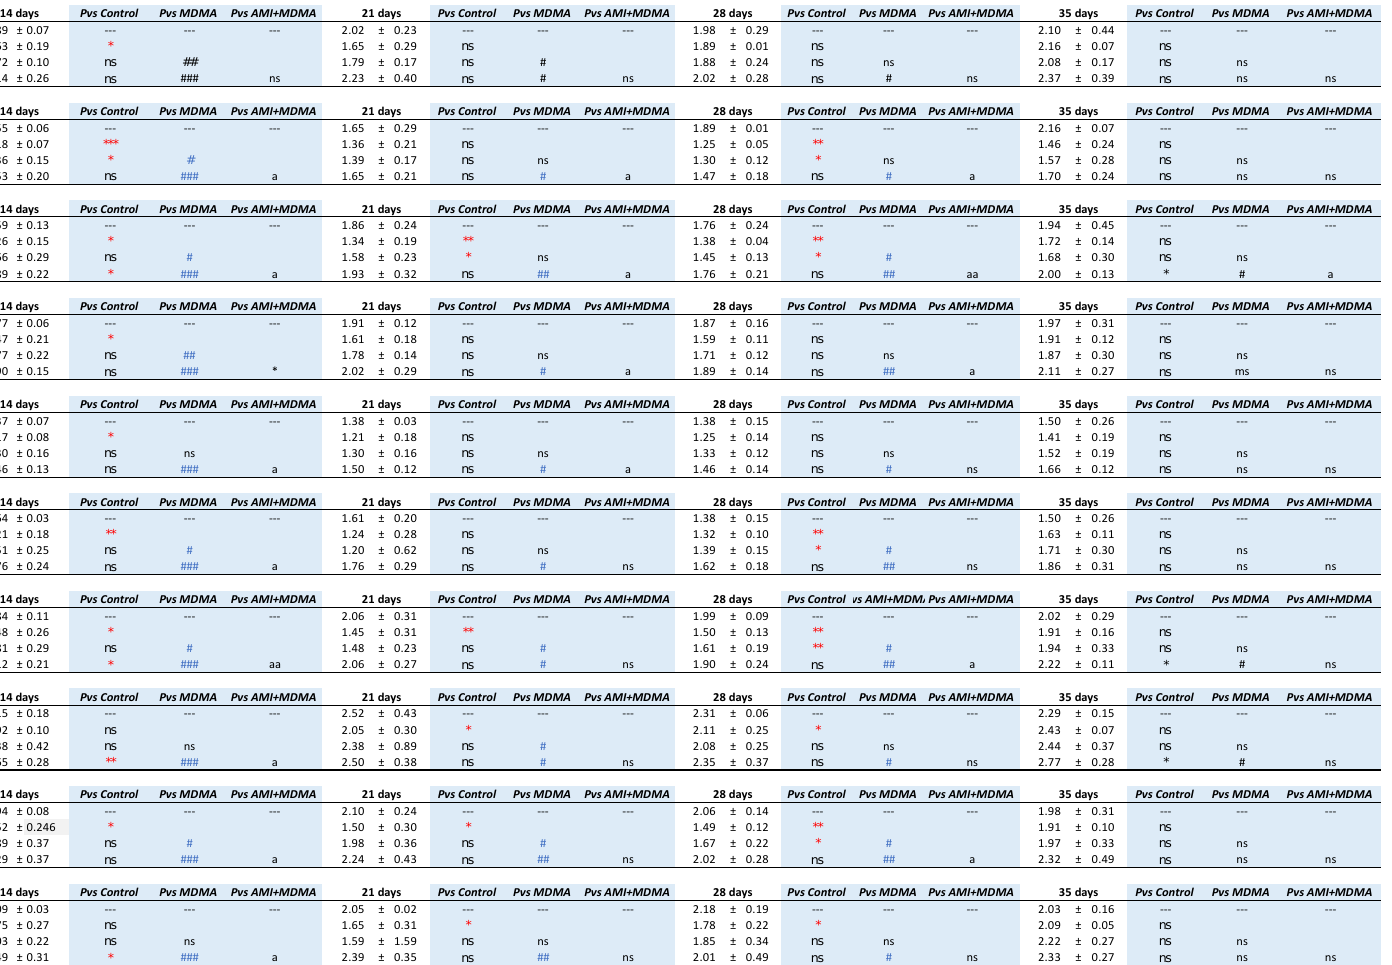
Figure 4. Specific uptake ratios (SURs) of 4-[ 18 F]-ADAM in 9 brain areas under different drug treatments from day 0 to day 35. Data are mean ± SD. Animals were grouped into (1) Group A: saline control; (2) Group B: MDMA; (3) Group C: AMI with MDMA; or (4) Group D: AMI alone. Different superscript symbols denote difference level of significance (red * p < 0.05, ** p < 0.01, *** p < 0.005 Group B or C or D vs. Group A; blue # p < 0.05, ## p < 0.01, ### p < 0.005, Group A or C or D vs. Group B; a p < 0.05, Group A or B or D vs. Group C, aa p < 0.01, ns = not